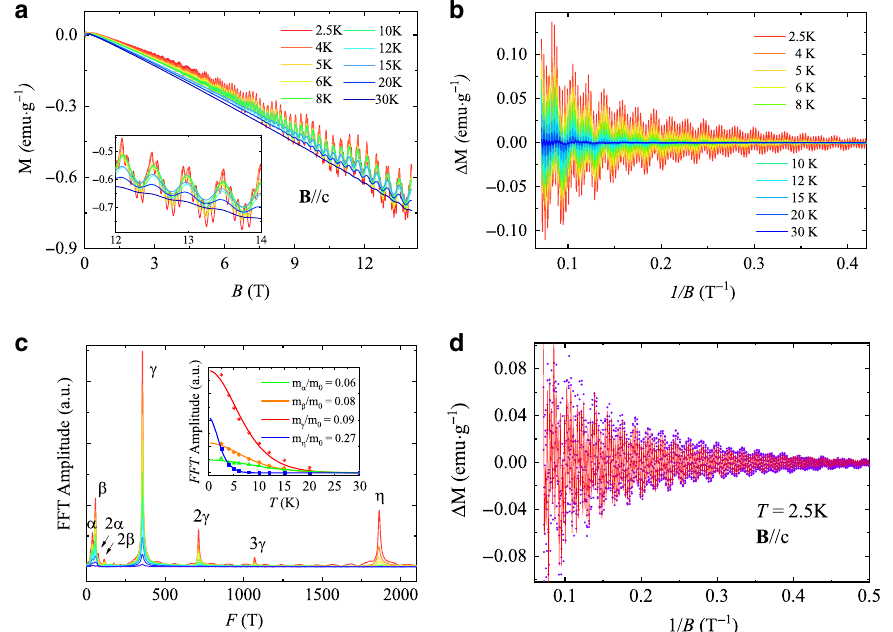
Fig. 2 dHvA oscillations of BaGa 2 . a The dHvA oscillation with B // c . b The oscillatory component Δ M as a function of 1/ B after subtracting a smoothing background. c FFT spectra of Δ M . Inset: The effective masses fi tted by the thermal factor of LK formula. d The LK fi tting (red line) of Δ M at 2.5 K.